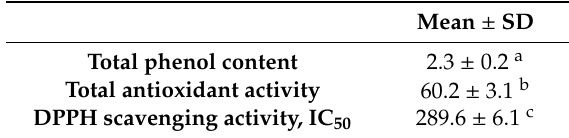
Table3. Totalphenolcontent, antioxidantactivity, and2,2-diphenyl-1-picrylhydrazylradicalscavenging activity IC50 of